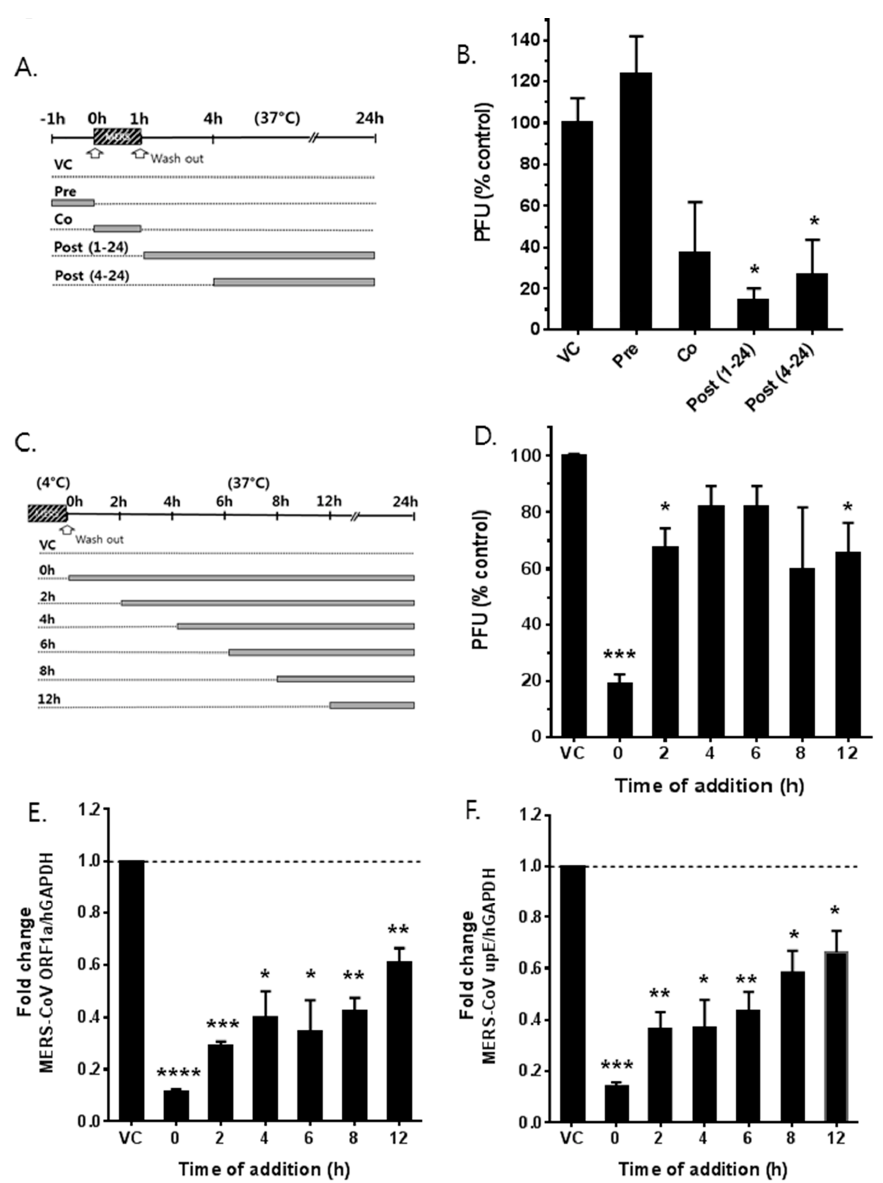
Figure 3. Saracatinib inhibits the early stages of MERS-CoV life cycle. ( A ) Schematic representation of time-of-addition/removal experiment. ( B ) Huh-7 cells were treated with 10 μ M saracatinib for 1 h prior to virus infection (pre) or 0.5% DMSO (virus control, VC), for 1 h during infection (co), at 1 h post-infection (post 1–24), and at 4 h post-infection (post 4–24). After 24 h, the amount of infectious viral particles released to culture supernatants was determined by plaque assay. All values represent means ± SD of two independent experiments performed in duplicate. Significant differences are indicated by * p < 0.05. ( C ) Schematic representation of time-of-addition experiment. Huh-7 cells were inoculated with MERS-CoV at 4 °C to allow attachment/binding. After 1 h incubation, plates were shifted to 37 °C to allow synchronous entry and infection. Saracatinib (10 μ M) was treated during the 4 °C incubation only or added at indicated time points during the 37 °C incubation and remained present until sample collection. After 24 h p.i.; ( D ) cell culture supernatants were collected for virus titration using plaque assay. ( E , F ) Total RNA isolated from infected lysates was used for analyses of intracellular MERS-CoV genomic RNA ( ORF1a ) and mRNA ( upE ) by qRT-qPCR. Data represent the means ± SD of two independent experiments performed in duplicate. Significant differences are indicated by * p < 0.05, ** p < 0.01, *** p < 0.001, **** p <